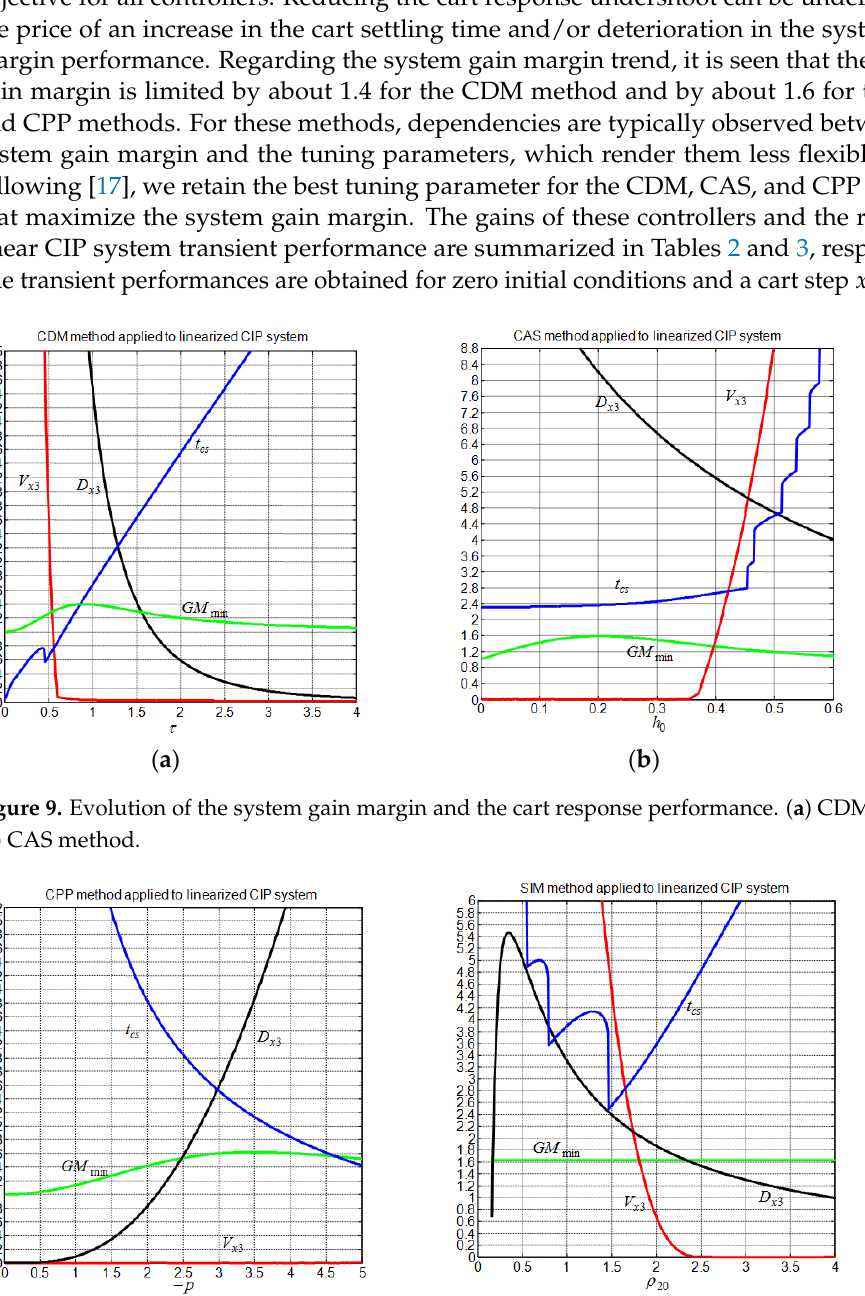
Table 2. State-feedback controller gains and associated parameters.